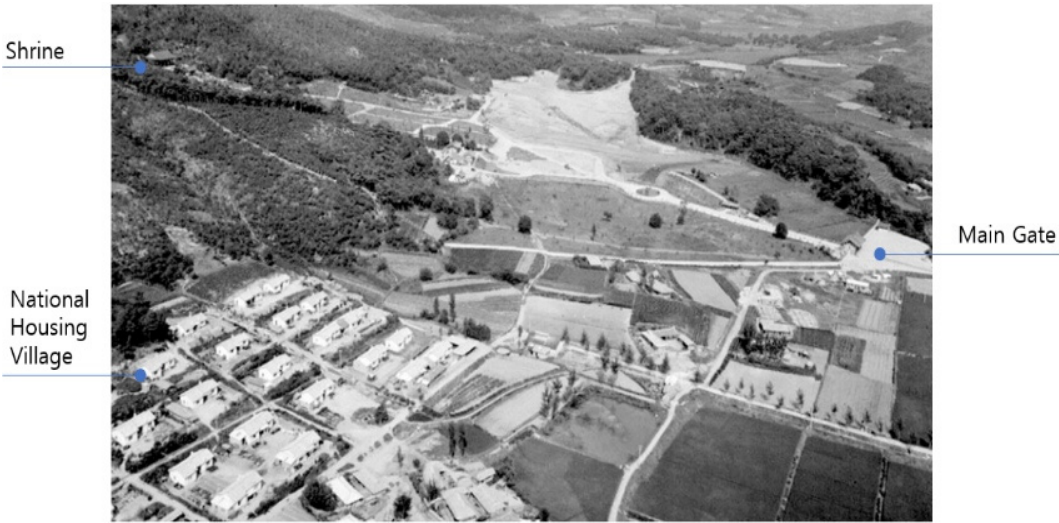
Figure 4. ( a ) Panoramic View of Hyeonchungsa in 1979 (Source: Kyunghyang Shinmun Newspaper) ( b ) Site Plan of Hyeonchungsa in 1967 (Source: Cultural Heritage Administration).